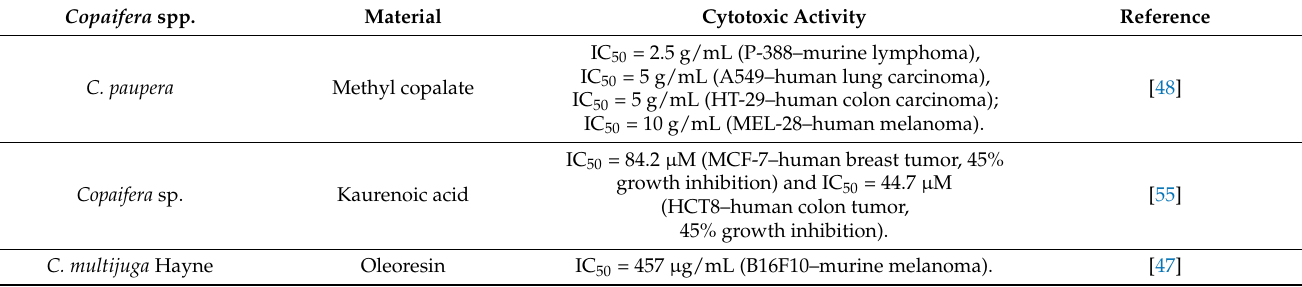
Table 1. Cytotoxic properties of the chemical constituents of oleoresins from Copaifera spp. Copaifera